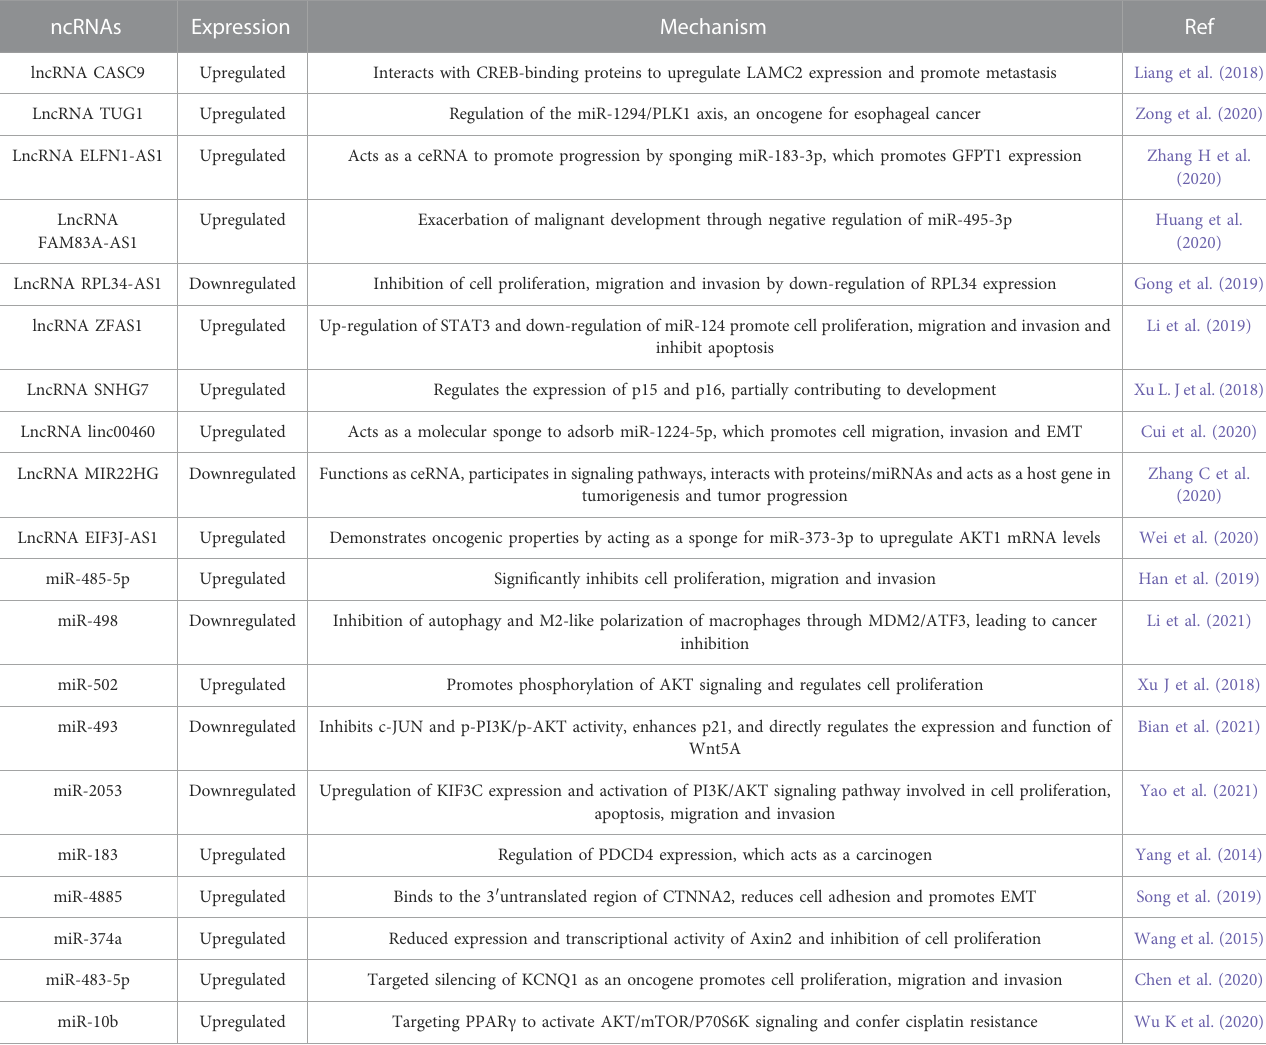
TABLE 2 Biomarkers of ncRNAs in esophageal